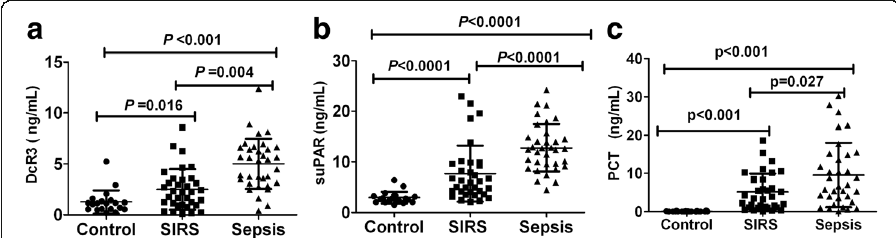
Fig. 1 Levels of DcR3, suPAR and PCT a : Minimum-maximum (median) value of serum DcR3 in sepsis ( n = 34), SIRS ( n = 34) and controls ( n = 20) by non-parametric Kruskal – Wallis test ( p < 0.001). b : mean ± SD value of serum suPAR in controls ( n = 20), SIRS ( n = 34) and sepsis ( n = 34), respectively, by Mann – Whitney test ( p < 0.001). c : Minimum-maximum (median) value of PCT in controls ( n = 20), SIRS ( n = 34) and sepsis